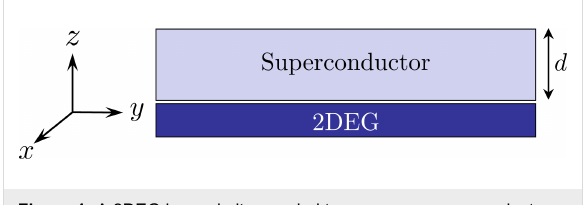
Figure 1: A 2DEG is proximity-coupled to an s -wave superconductor with finite thickness d . Both systems are taken to be infinite in the xy